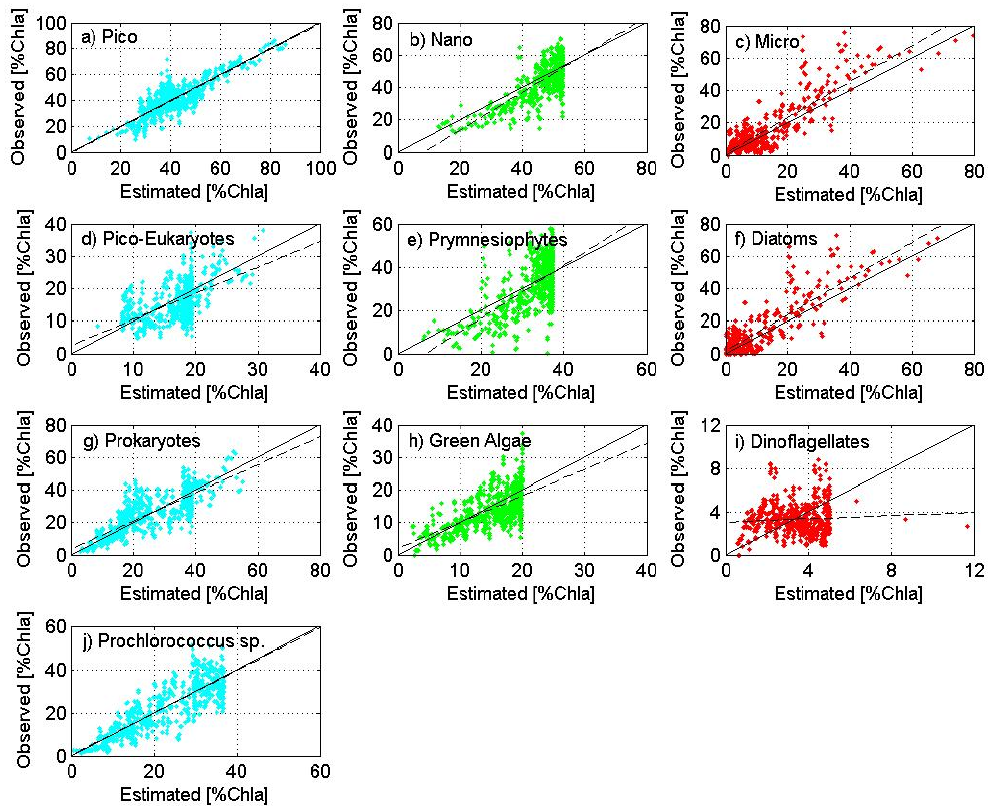
Fig. 4. Results of validation; (a) Picoplankton, (b) Nanoplankton, (c) Microplankton, (d) Pico-eukaryotes, (e) Prymnesiophytes (Hapto- phyotes), (f) Diatoms, (g) Prokaryotes, (h) Green algae, (i) Dinoflagellates, (j) Prochlorococcus sp. The root mean square error, RMSE (%Chl- a ), is also calculated by SQRT { 6 (X obs -X fit ) 2 /n } where n represents the number of data. See Table 4 for statistical details.